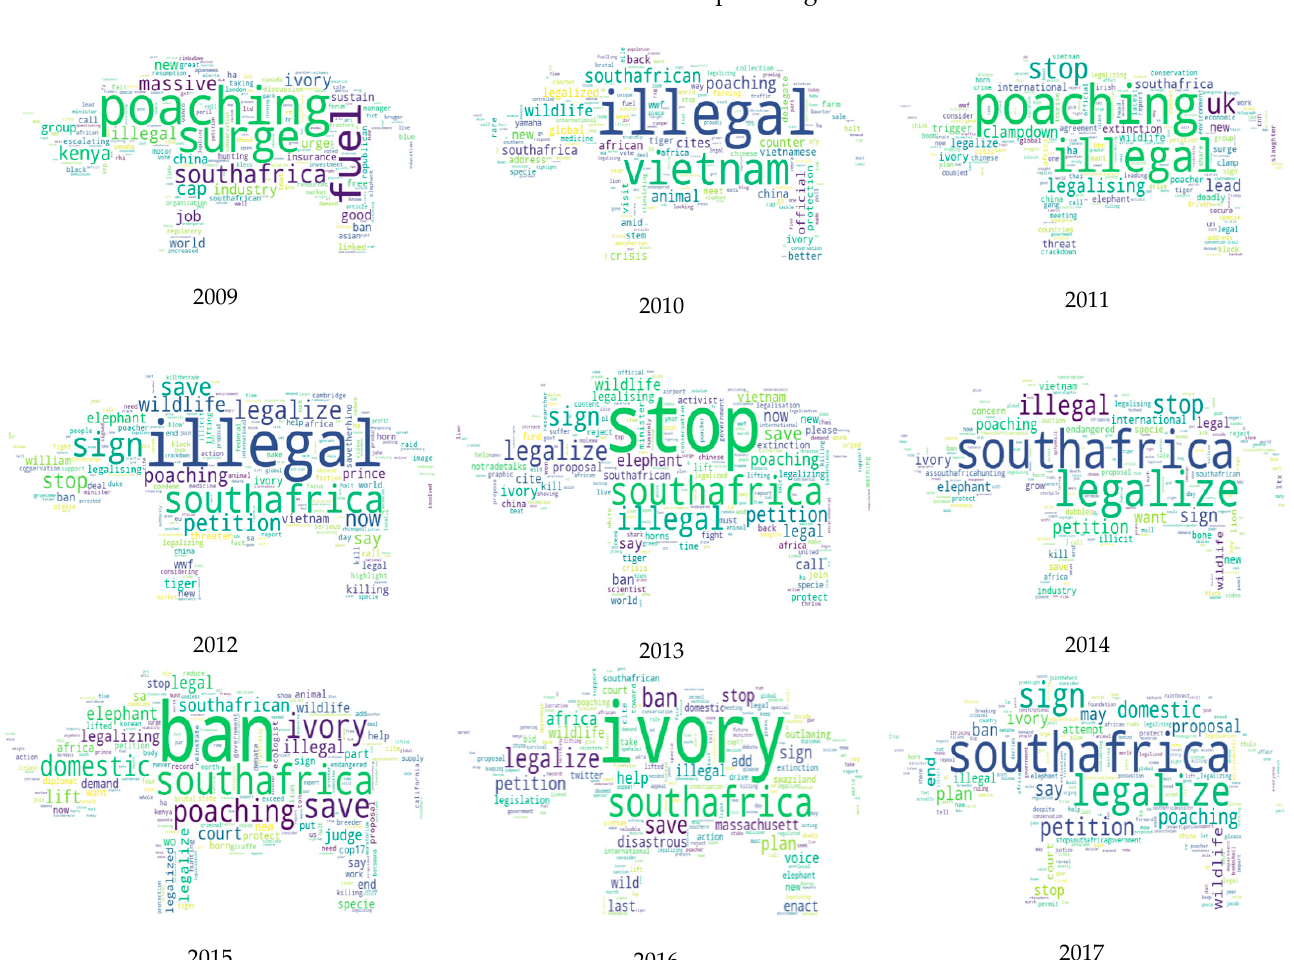
Figure 7. Word cloud of tweets each year from 2009 to 2017.